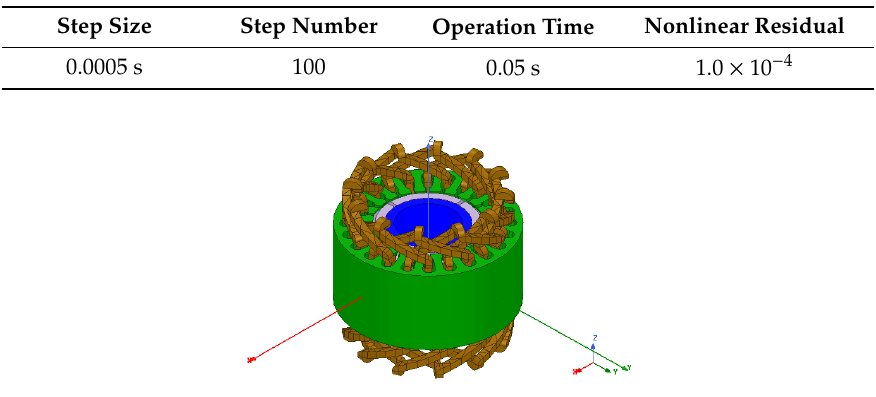
Figure 4. Finite element solution model of the generator.